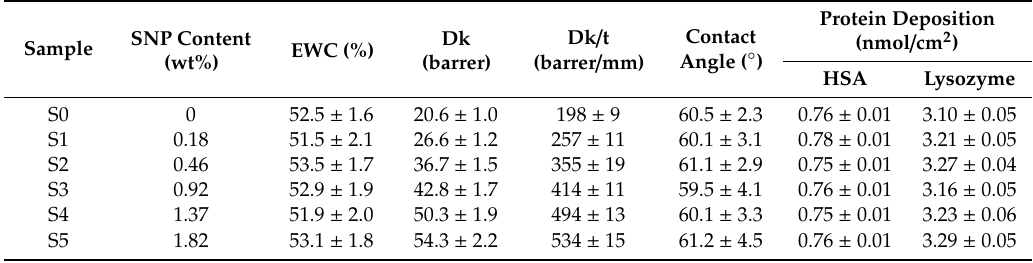
Table 1. Hydrophilicity, oxygen permeability, wettability and protein deposition of SNP-loaded contact